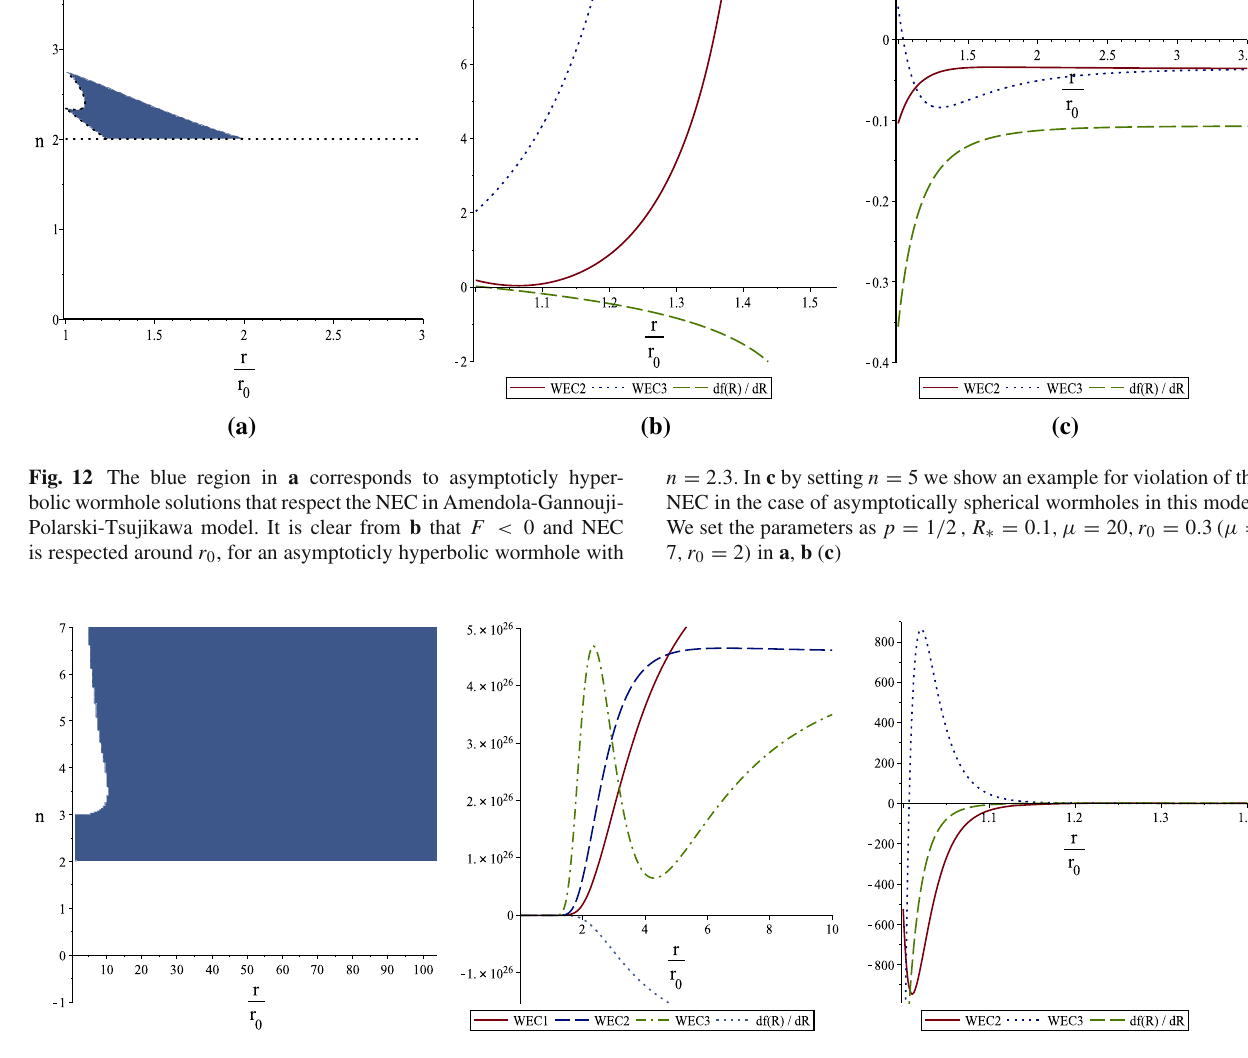
have plotted F and WEC1,2,3 for an asymptoticly hyperbolic worm- hole with n = 2 . 5. In the case of c 1 = 1, Fig (13.c) shows that the NEC is violated at the throat for a wormhole with n = 4. In these figures we set λ = 2 , R ∗ = 0 . 1 and r 0 = 1